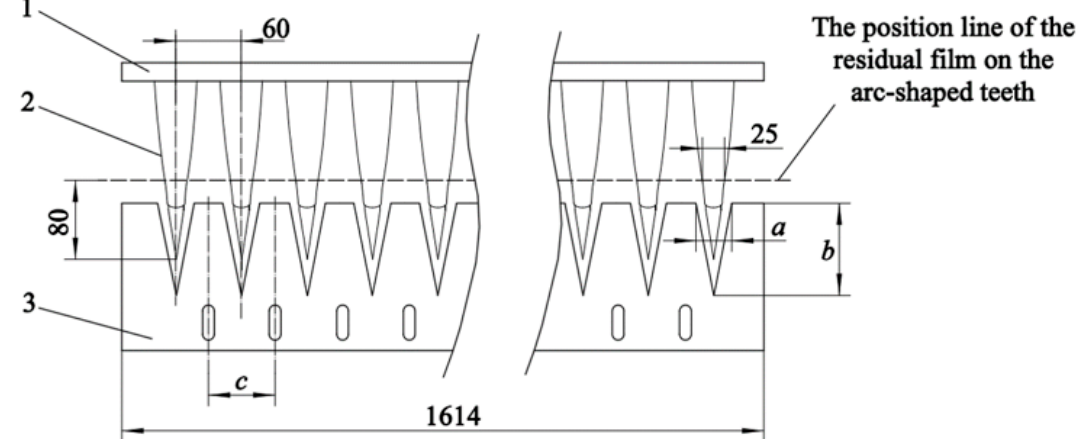
Figure 3. Schematic diagram of the working of blade and arc-shaped tooth. 1. Spoke plate. 2. Arc-shaped tooth. 3. Blade. Note: a is the maximum distance between the teeth of adjacent blades, mm; b is the tooth height of the blade, mm; c is the distance between adjacent teeth, mm.